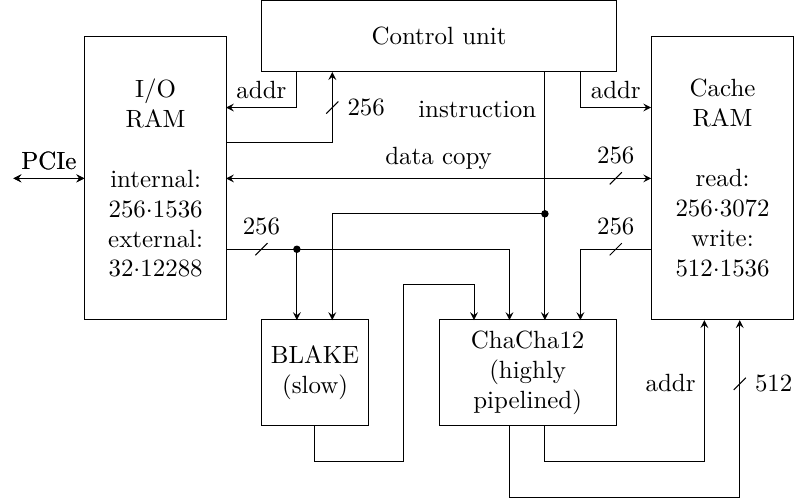
Figure 3: SPHINCS-256 co-processor